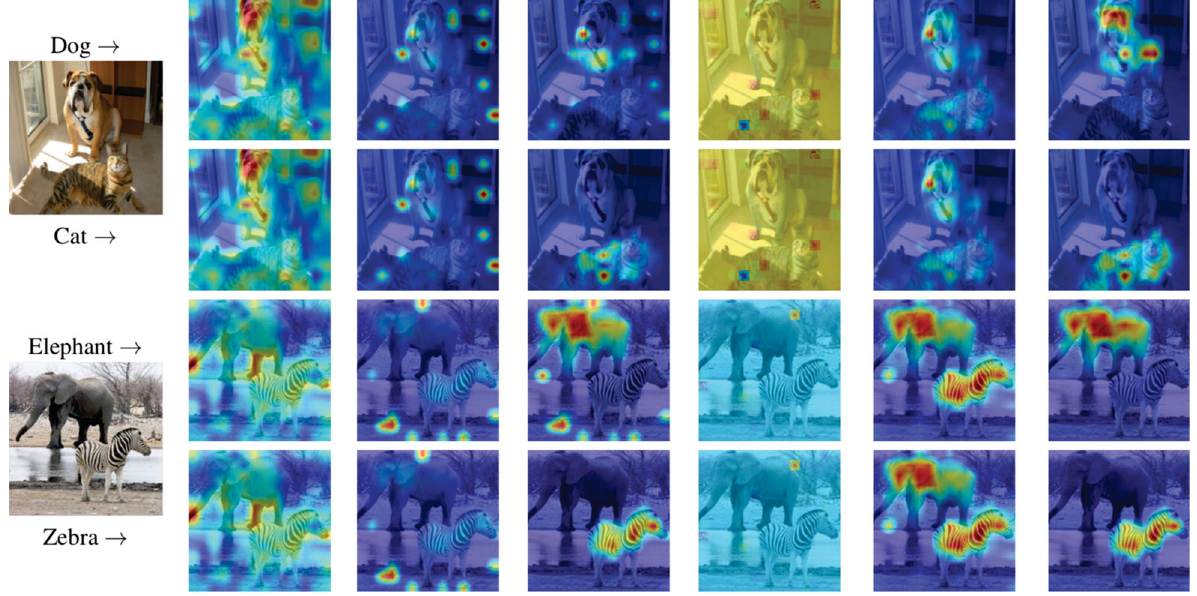
Fig. 8 Class-specific visualization results from ViT. Left to right: input image, rollout [62], raw-attention, GradCAM [72], LRP [73], partial LRP [63], and Transformer-Explainability [23]. Reproduced with permission from Ref. [23], c (cid:2) The Author(s) 2021. (cid:2)